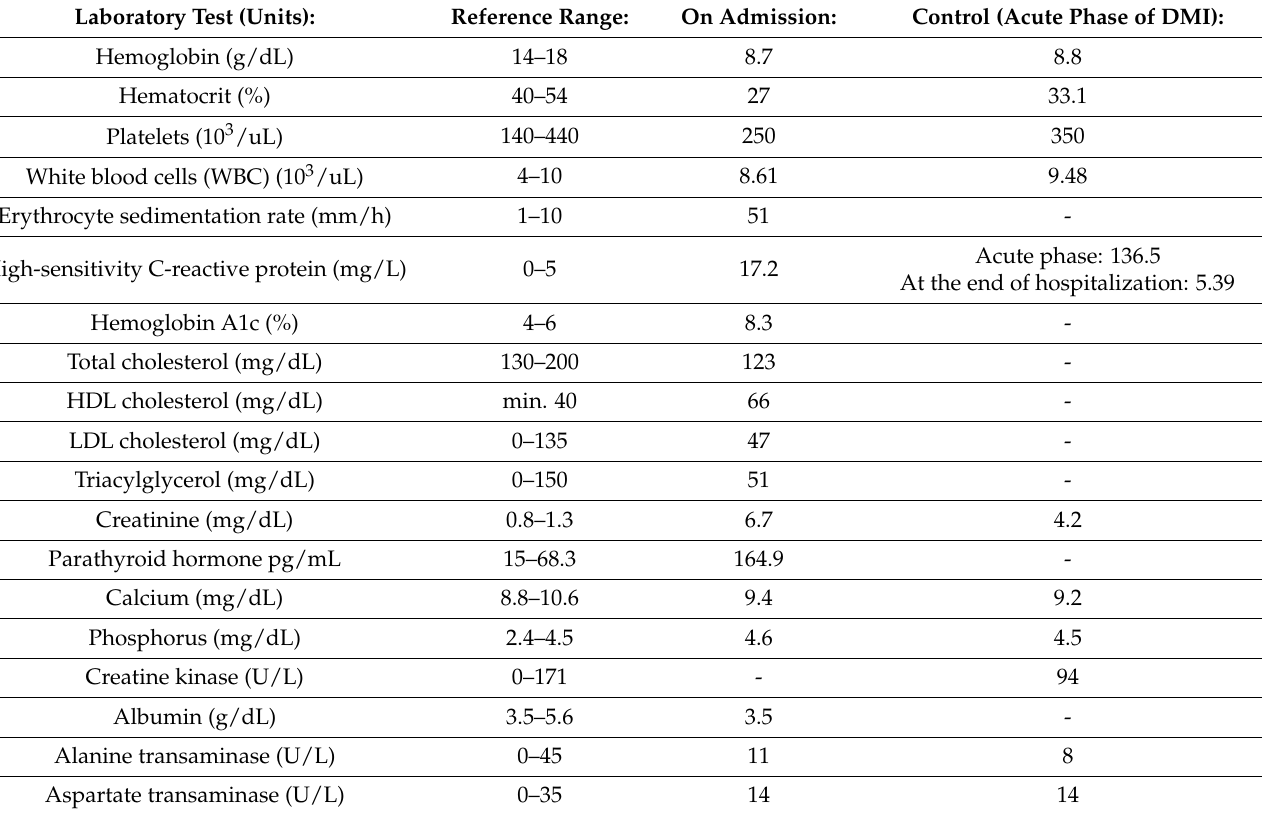
Table 1. The results of the patient’s laboratory test at the beginning of hospitalization and in the